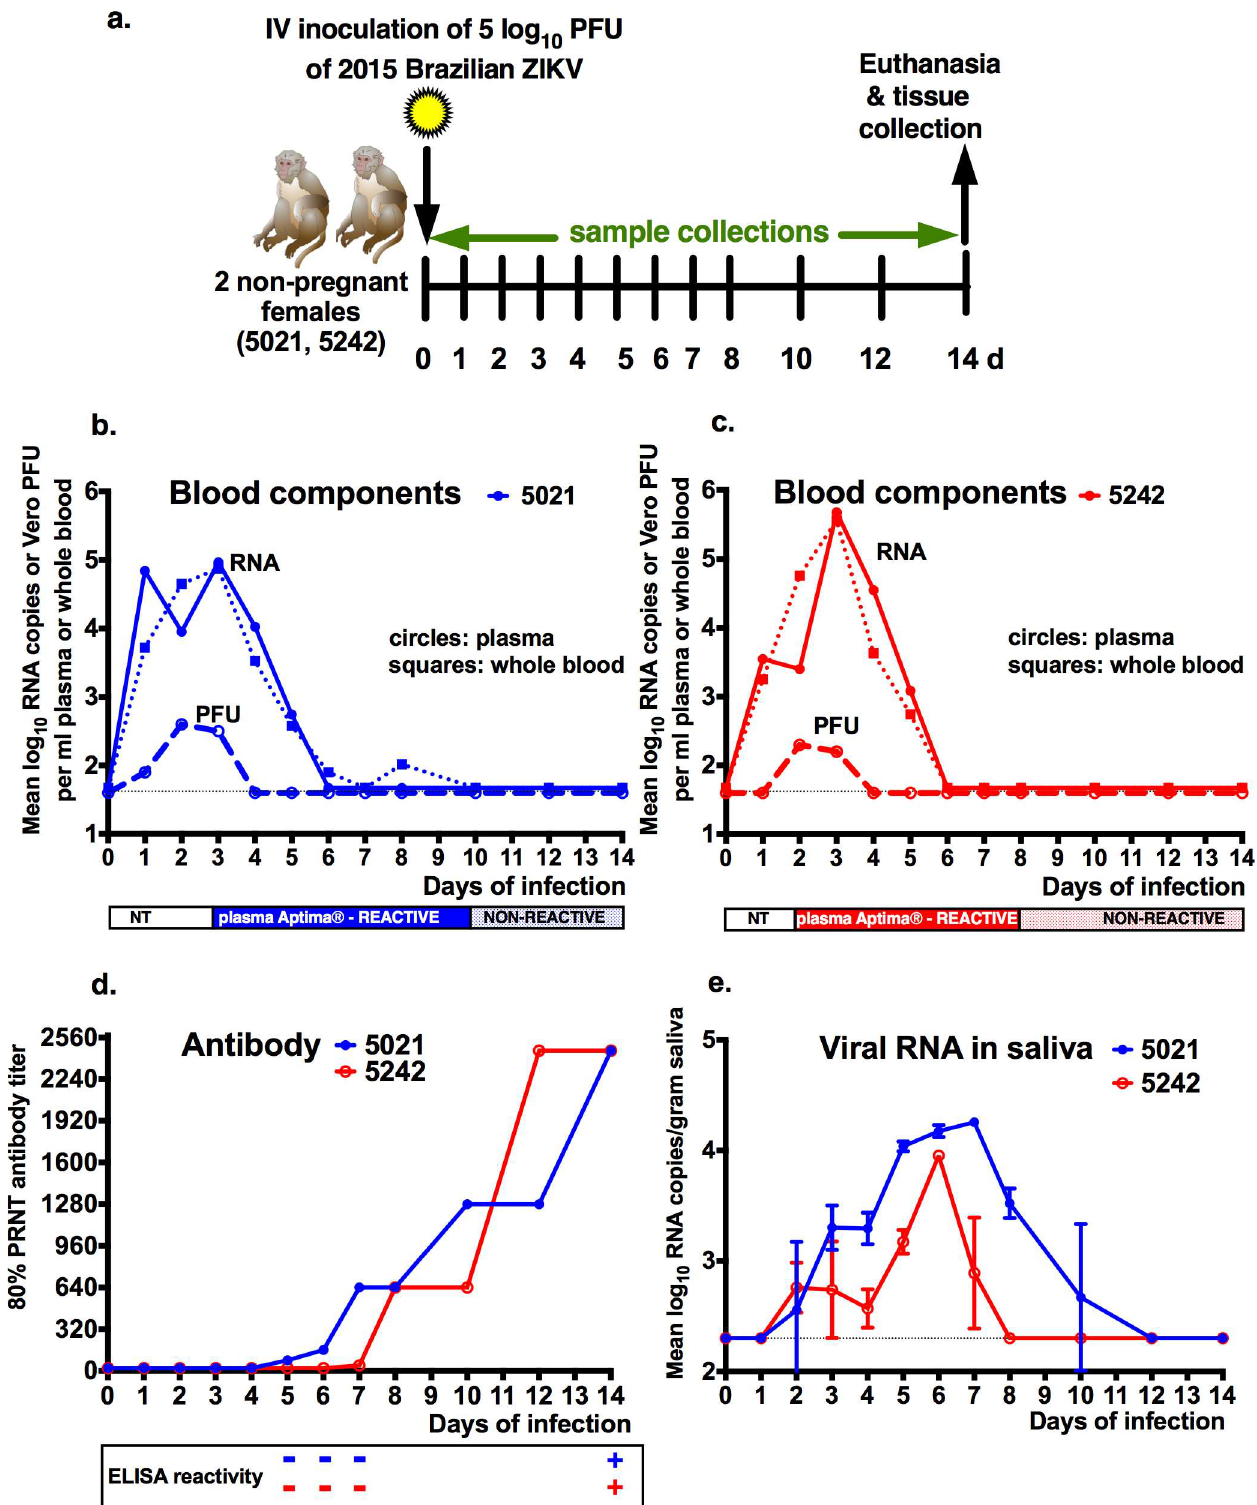
Fig 1. ZIKV infection of 2 adult macaques. a) Virus inoculation and samplingtimeline. Two West Nile virus-antibody negativenon-pregnant female macaquesreceivedan intravenousinoculationof 5.0 log 10 PFU of a 2015 BrazilianZIKV strain on day 0. Signs of clinical diseasewere recordedtwice daily. Animals were anesthetized daily from 1 to 8 then on 10, 12 and 14 dpi for blood collectionand euthanizedfor tissue